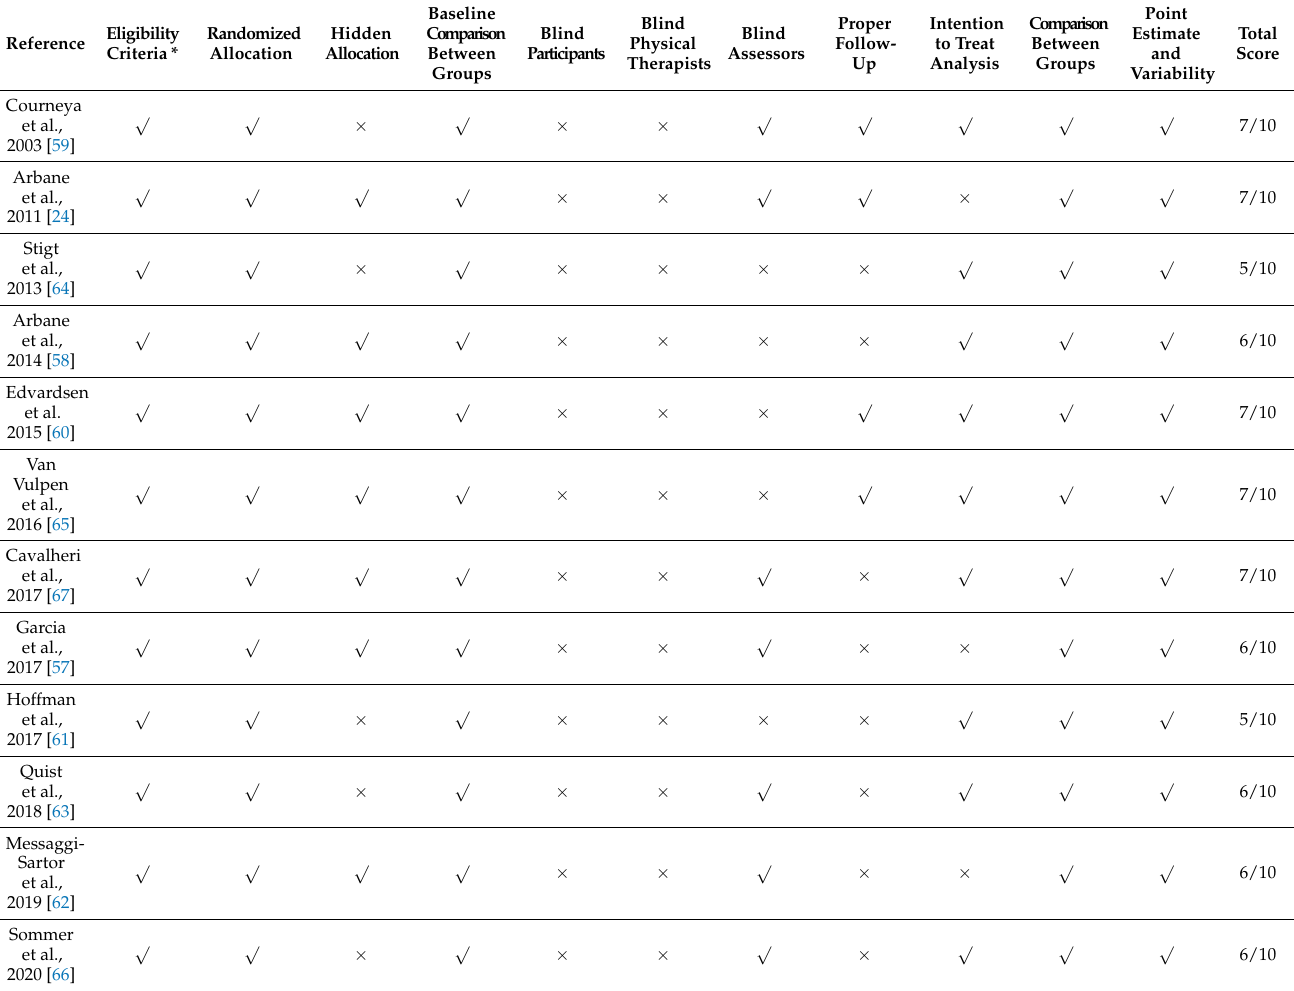
Table 3. Methodological quality assessment using the PEDro scale (12